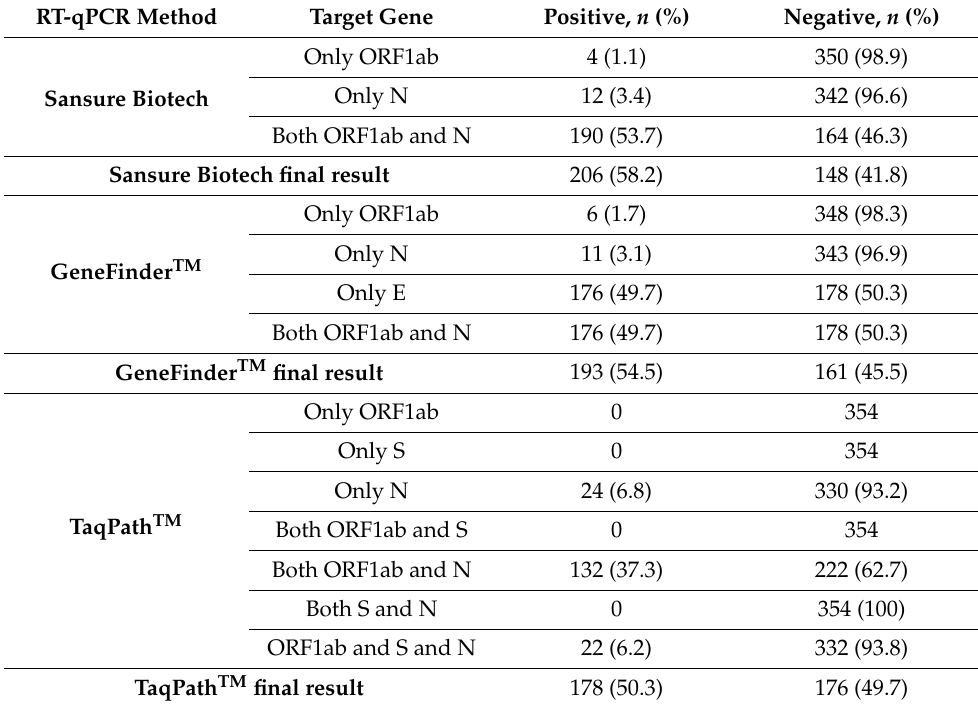
Table 2. Results and comparison of three different RT-qPCR methods tested on 354